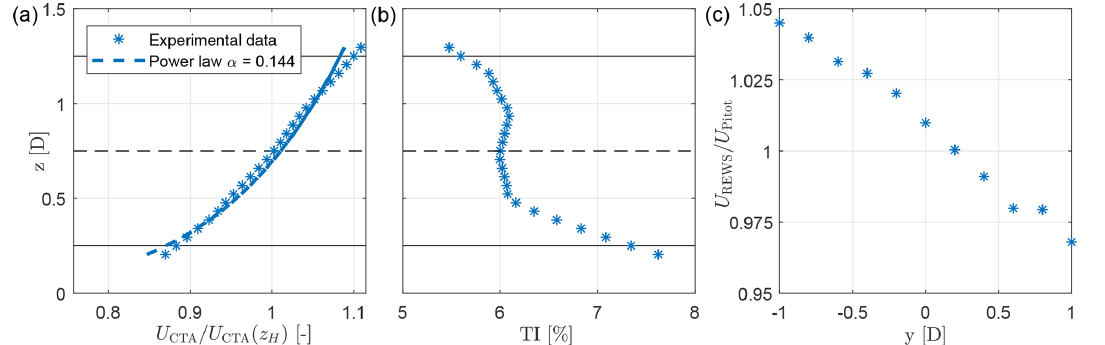
Figure 3. Characteristics of the wind tunnel boundary layer: vertical profiles of wind speed (a) and turbulence intensity (b) , measured with CTA probes; lateral profile of the wind speed (c) , measured using the rotor as a